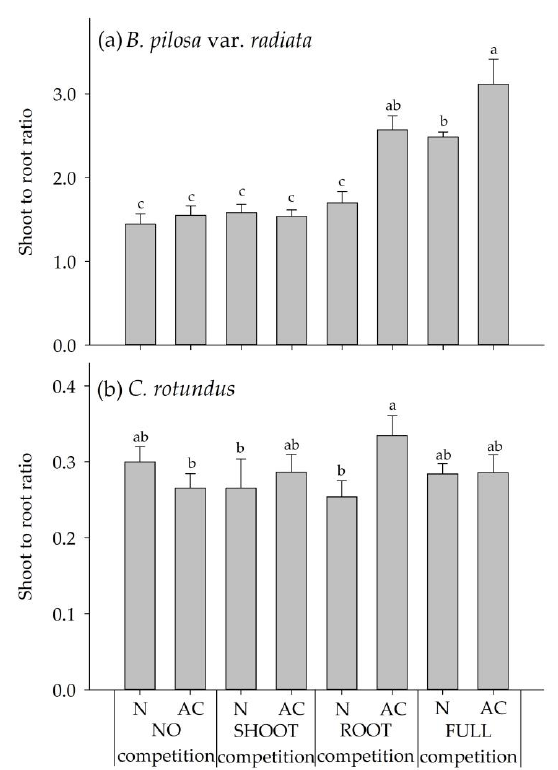
Figure 3. Shoot to root ratio of BPr and CR when grown with two activated carbon application treatments and subjected to four competition modes. ( a ) Shoot to root ratio of BPr . ( b ) Shoot to root ratio of CR . AC and N denoted pots added with and without activated carbon application, respectively. Error bars are the standard error of mean ( n = 5). Means with the same letter(s) are not significantly di ff erent at 5% level by LSD test. Data were log-transformed prior to analysis.